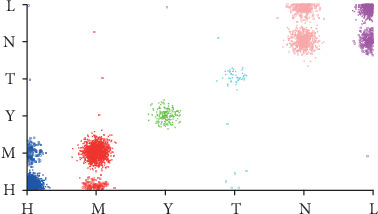
Illustration of errors of the Logistic algorithm.